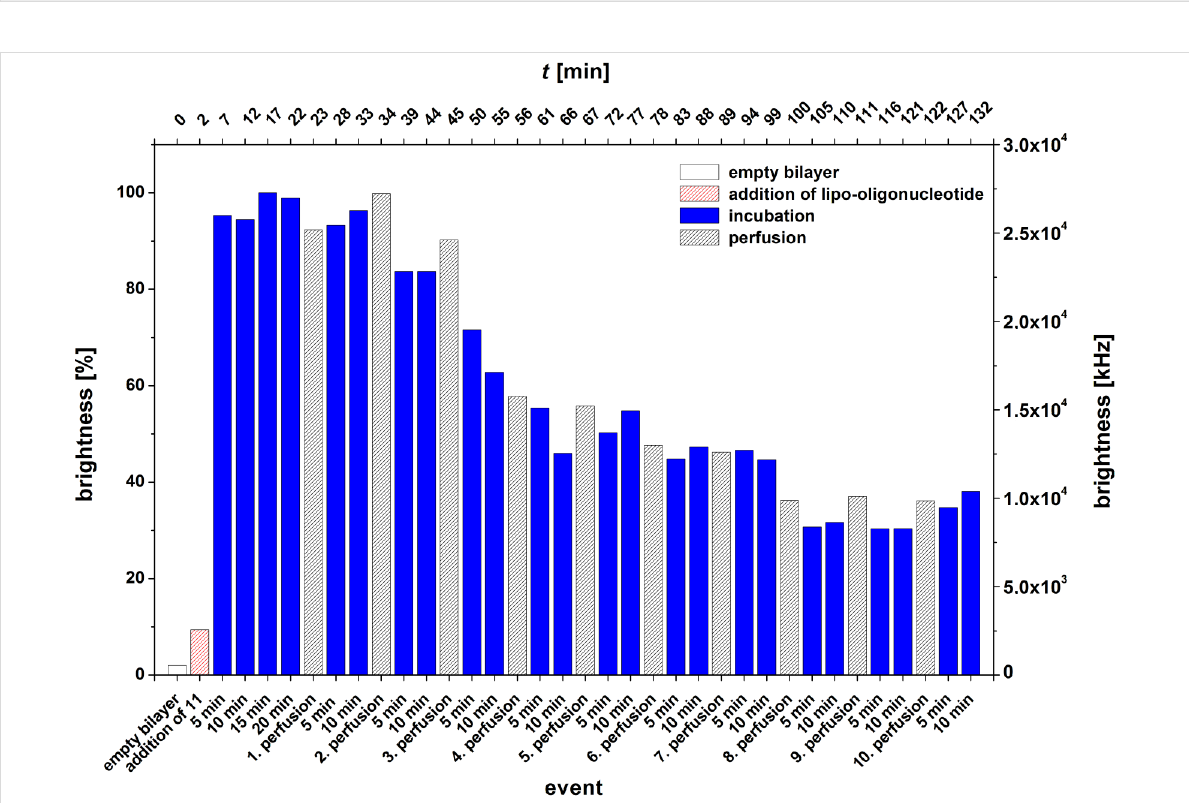
Figure 6: Bilayer brightness vs event graph of 5’-d( 5a -Cy5-TAG GTC AAT ACT) ( 11